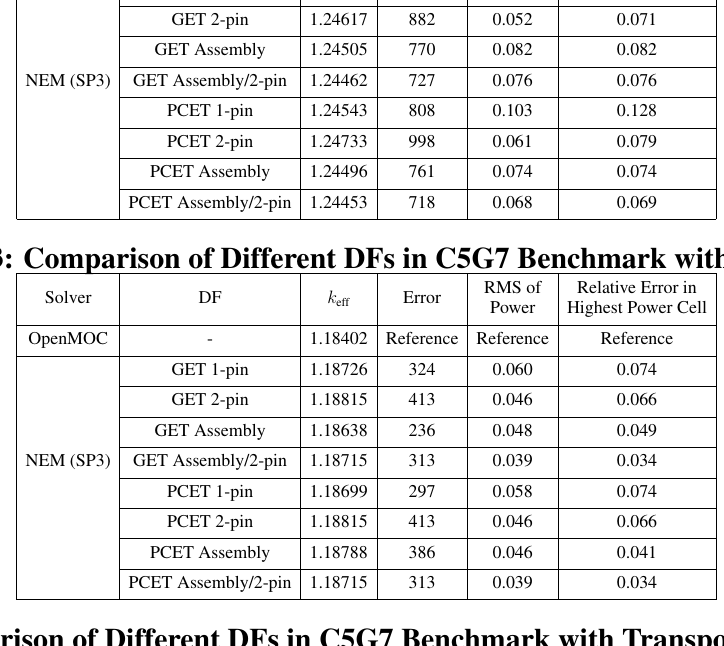
Table 4: Comparison of Different DFs in C5G7 Benchmark with Transport Corrected